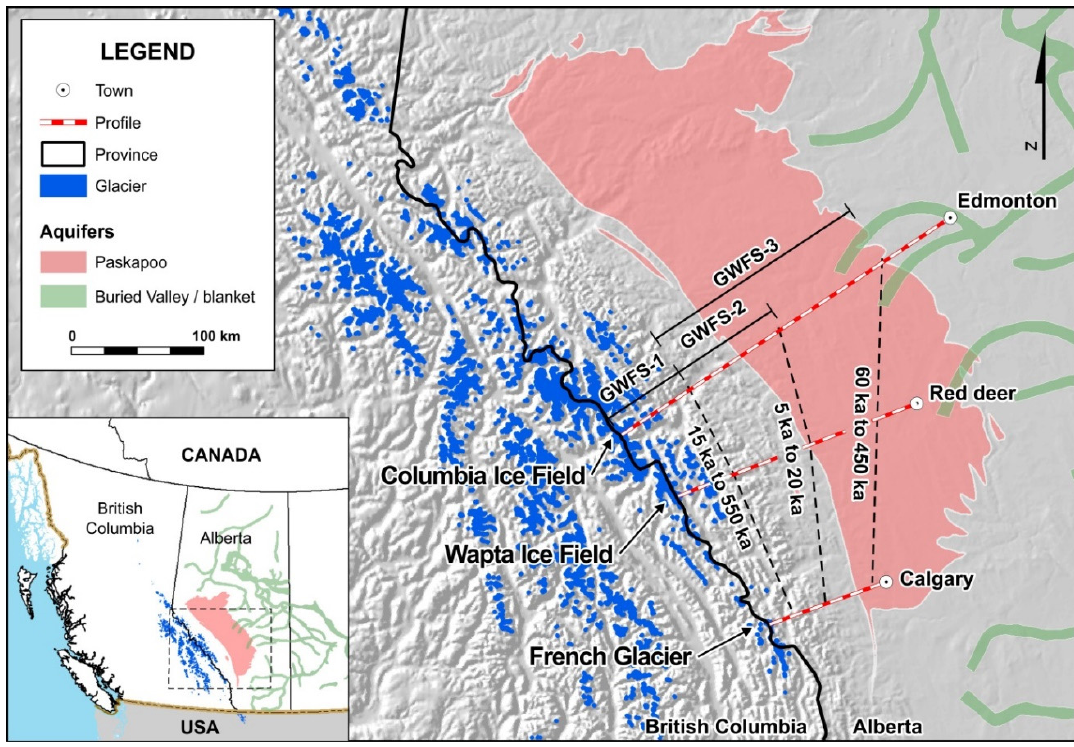
Figure 19. Regional-scale groundwater flow systems (GWFS).